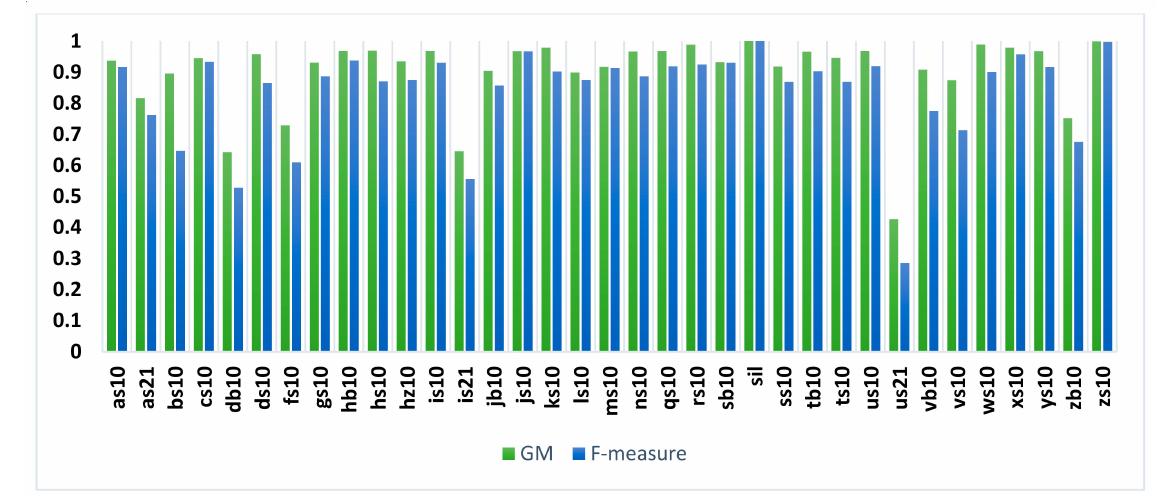
Figure 13. Geometric mean (GM), and F-measure of an Arabic phonemes of the KAPD corpus using YOLOv3-tiny-1S model.